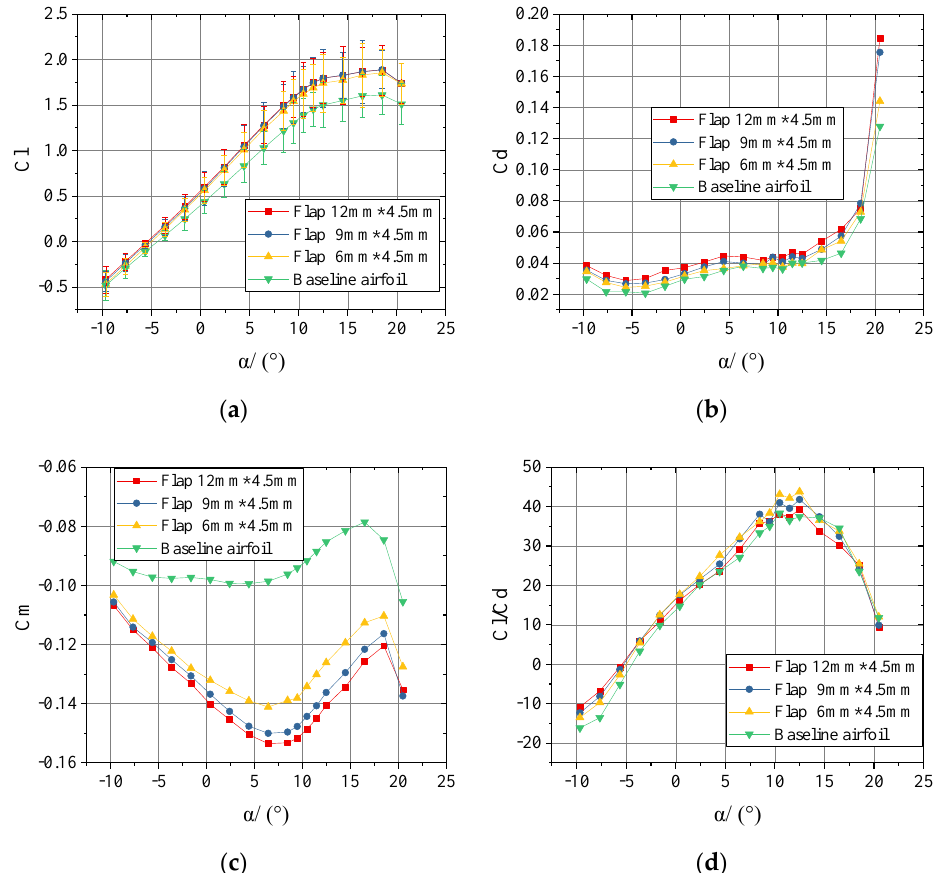
Figure 12. Variation of the aerodynamic characteristics with different heights of Gurney flaps (T.I. of 10.5%, Re: 0.8 × 10 6 ). ( a ) Lift coefficient comparison; ( b ) drag coefficient comparison; ( c ) pitching-moment coefficient comparison; ( d ) lift-to-drag ratio comparison.